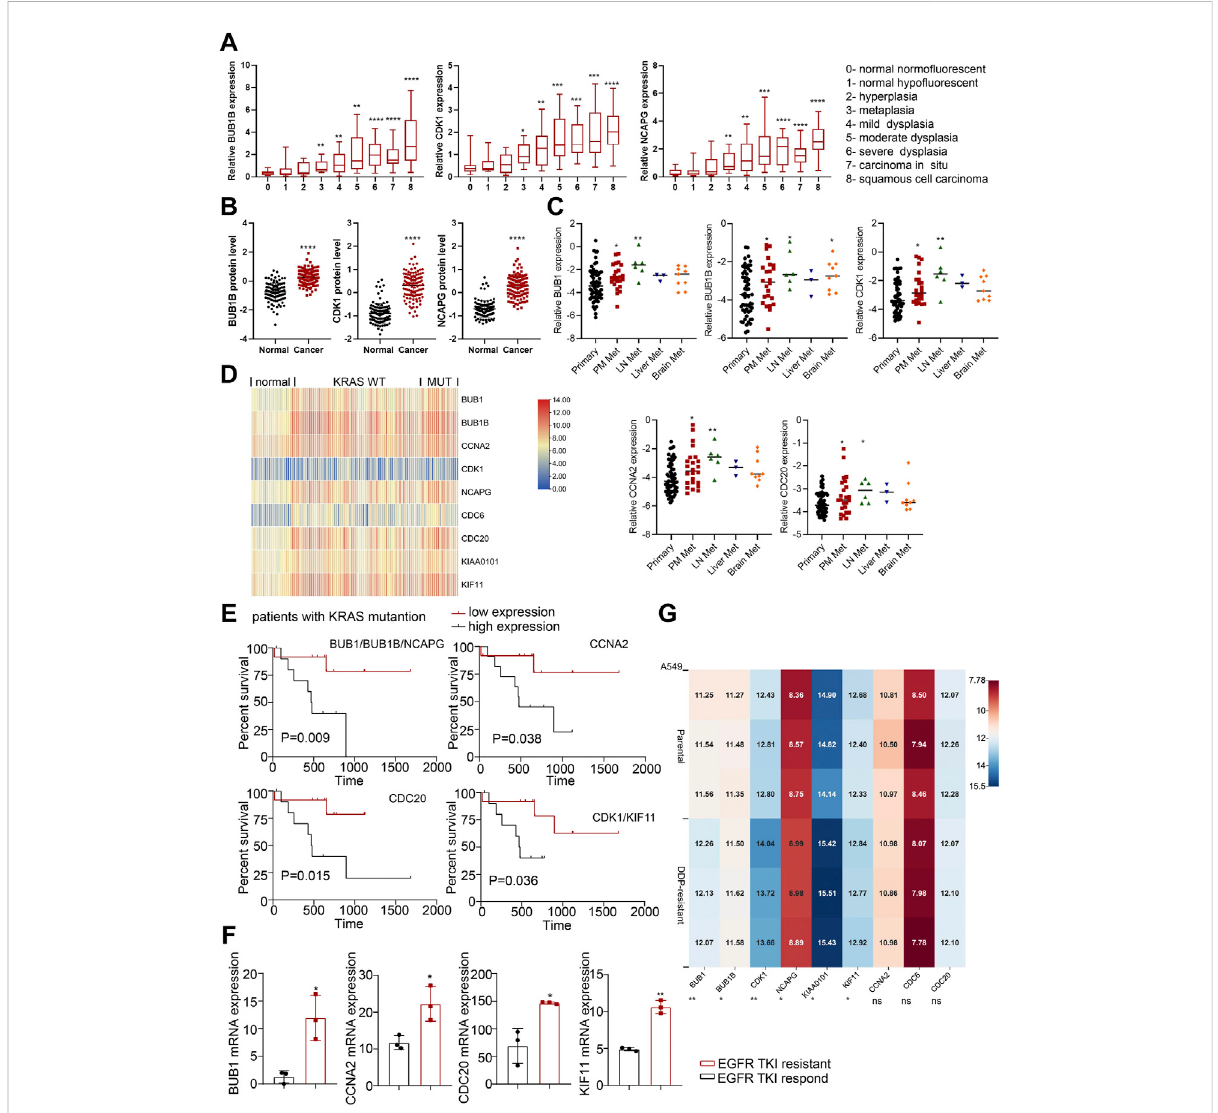
FIGURE 4 The roles of hub genes in LUSC and in EGFR- or KRAS-mutation driven NSCLC. (A) The expression levels of hub genes in different stages of LUSC tumorigenesis (122 samples from 77 patients). (B) The protein expression levels of hub genes in LUSC in CPTAC database. (C) The expression levelsofhubgenes(BUB1,BUB1B,CDK1,CCNA2andCDC20)inlungadenocarcinomasidenti fi edpatientswithdismalprognosis.GSE13213:Primary lung cancer: n = 58; PM metastasis: n = 24; LN metastasis: n = 6; Liver metastasis: n = 3; Brain metastasis: n = 9. (D) Heatmap of hub gene expression in KRAS-mutant and KRAS-wild type lung cancer compared to normal lung tissues (GSE31210). Normal lung: n = 20, KRAS MUT: n = 20, KRASWT:n=68. (E) Kaplan-MeieranalysisofhubgenesinLUADwithKRASmutationfromTCGA. (F) HubgeneexpressioninEGFR-TKI-sensitiveand TKI-resistant lung cancer tissues in GSE161584 dataset. (G) Heatmap of hub gene expression in DDP-resistant A549 cells and control cells (GSE108214). * p < 0.05, ** p < 0.01, *** p < 0.001, **** p <